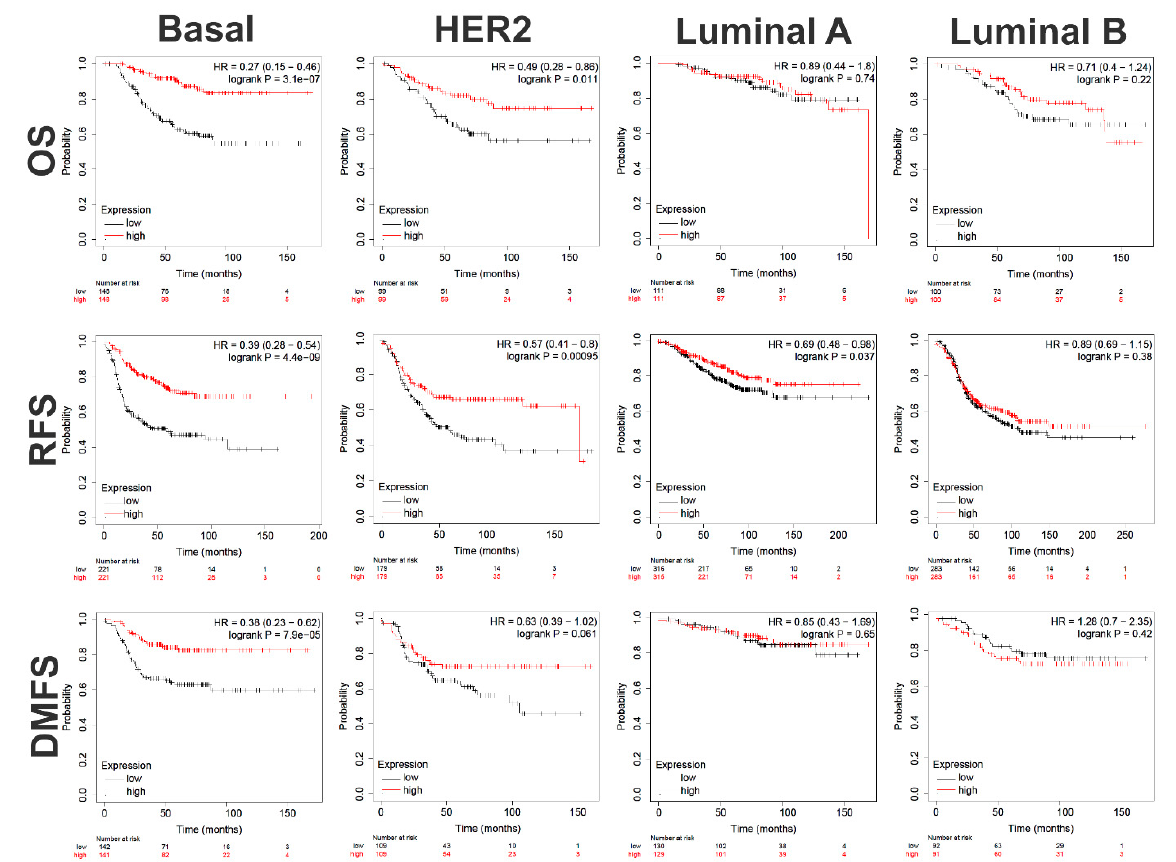
Figure 8. Survival analysis of an 87-immune-gene signature in independent breast cancer cohorts. The identified 87-immune-gene signature predictive of pCR was subjected to RFS, OS, and DMFS in a cohort of basal (RFS: n = 442, OS: n = 296, DMFS: n = 283), HER2+ (RFS: n = 358, OS: n = 198, DMFS: n = 218), Luminal B (RFS: n = 566, OS: n = 200, DMFS: n = 183), and Luminal A (RFS: n = 631, OS: n = 222, DMFS: n = 259).